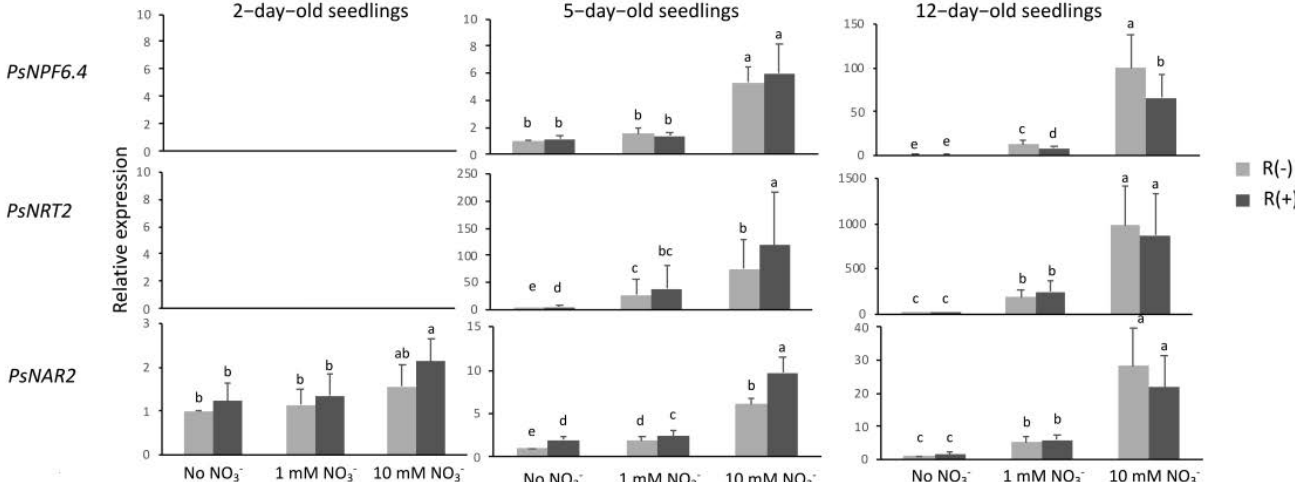
Figure 3. Relative expression of nitrate-inducible genes. The samples and the conditions used for RT- qPCR experiments were the same as those described in the legend of Figure 1. PsNPF6.4 , NRT1/PTR Family 6.4, and PsNRT2 / PsNAR2 , the two component high-affinity nitrate transport system. Data presented are means of three independent experiments performed in triplicate. Error bars indicate SE. Letters denote significant differences at the 0.05 level (multiple